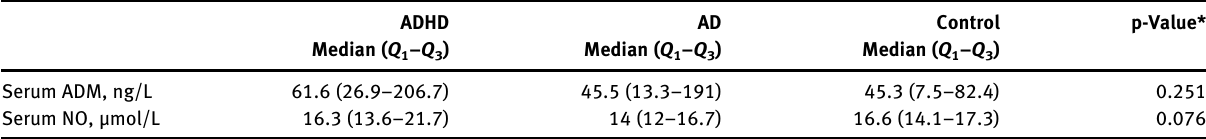
Table  : Serum adrenomedullin and nitric oxide levels of ADHD, AD and control